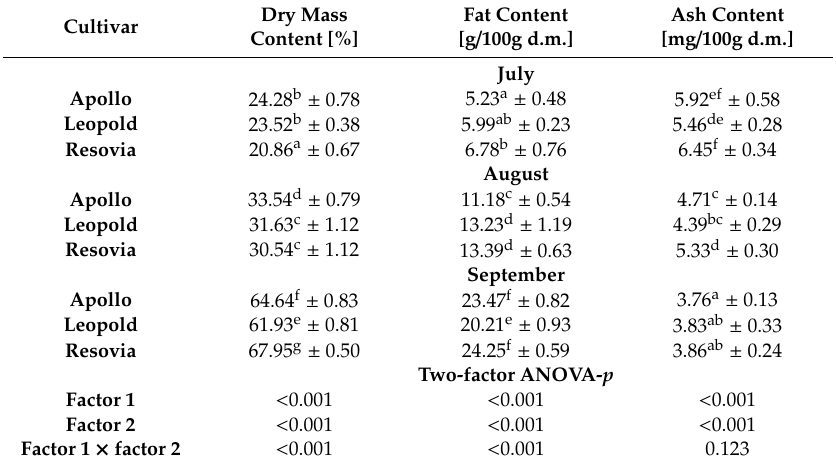
Table 1. Parameters showing physicochemical properties of walnuts in di ff erent stages of ripeness.